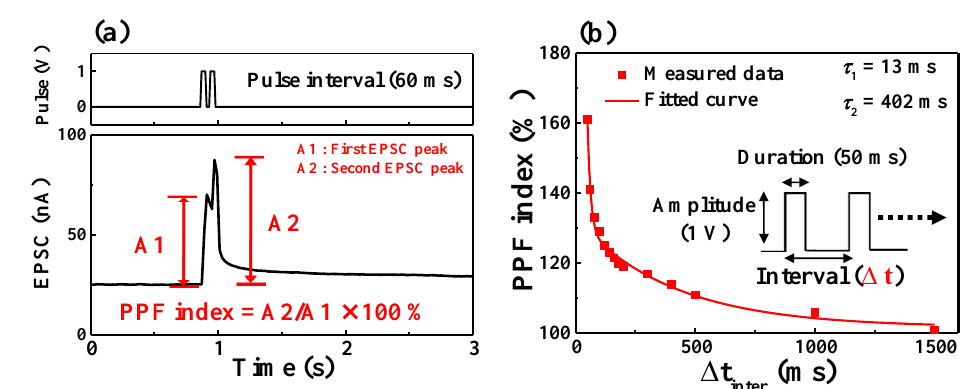
Figure 4. ( a ) EPSC triggered by a pair of pulses with a 60 ms interval; ( b ) paired-pulse facilitation (PPF) index (A2/A1) as a function of the pulse interval. The solid line corresponds to the fitting curve of the double-phase exponential function.